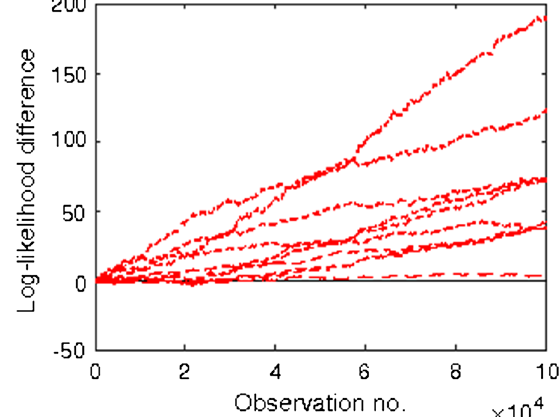
FIG. 22. Posterior probability P ( L j X ð 1 ∶ N Þ ) as a function of the number of layers L , computed from a trajectory of N ¼ 20 × 10 3 time steps generated using a model with L ¼ 5 and parameters T ð 1 Þ ¼ 0 . 1 , T ð 2 Þ ¼ 0 . 2 , T ð 3 Þ ¼ 0 . 6 , T ð 4 Þ ¼ 0 . 7 , T ð 5 Þ ¼ 0 . 9 , and 1 − r ¼ 0 . 85 . The algorithm clearly picks out the correct model L ¼ 5 . These results are obtained using the NPMC